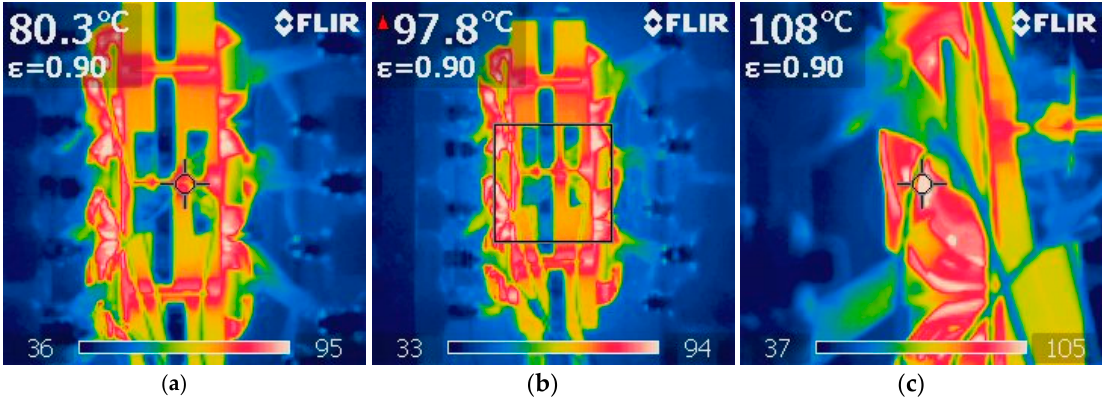
Figure 11. Thermal pictures for ( a ) thermal core temperature, ( b ) average temperature region and ( c ) temperature in windings.